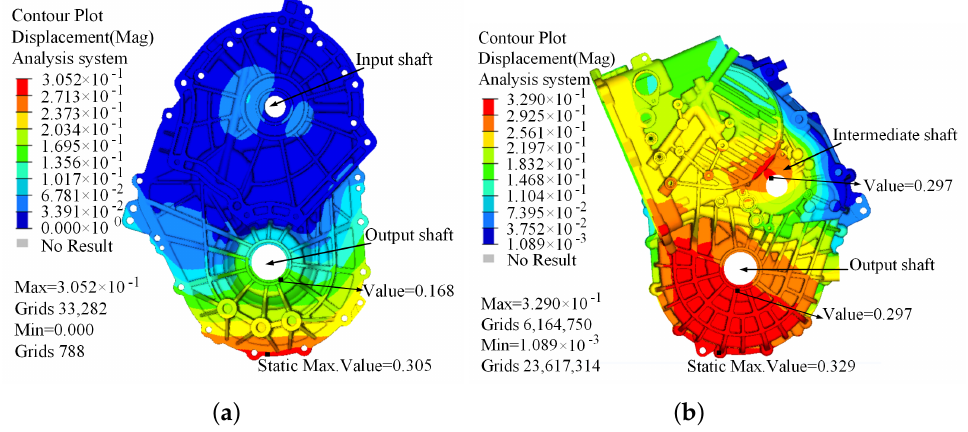
Figure 11. The static stiffness simulation results of the gearbox housing. ( a ) Deformation of the front gearbox housing. ( b ) Deformation of the rear gearbox